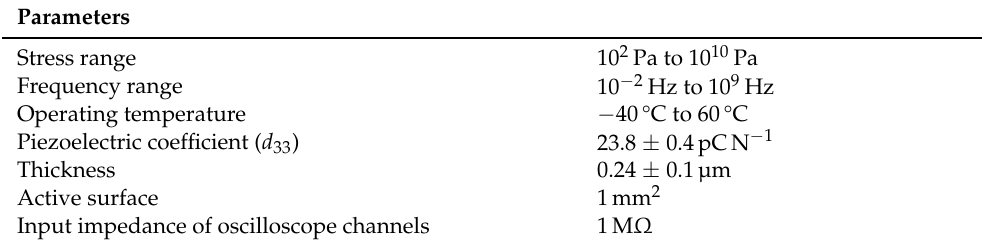
Table 1. Characteristics of the used PVDF sensor.